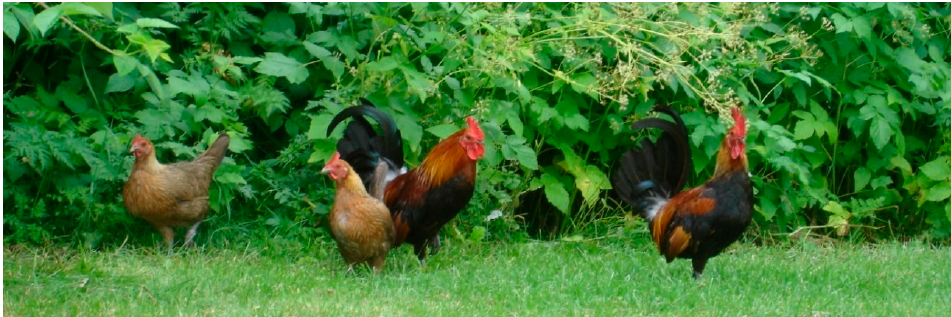
Figure 1. Free-ranging group of a Swedish game breed of domestic fowl.